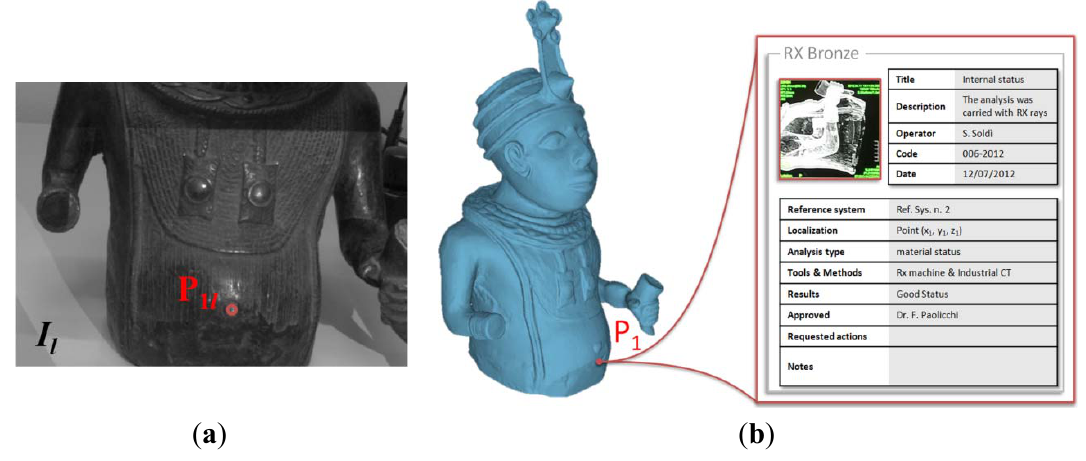
Figure 9. ( a ) 2D selection of a reference point on the left stereo image. ( b ) Radiographic analyses associated to the virtual model by using the correspondent 3D